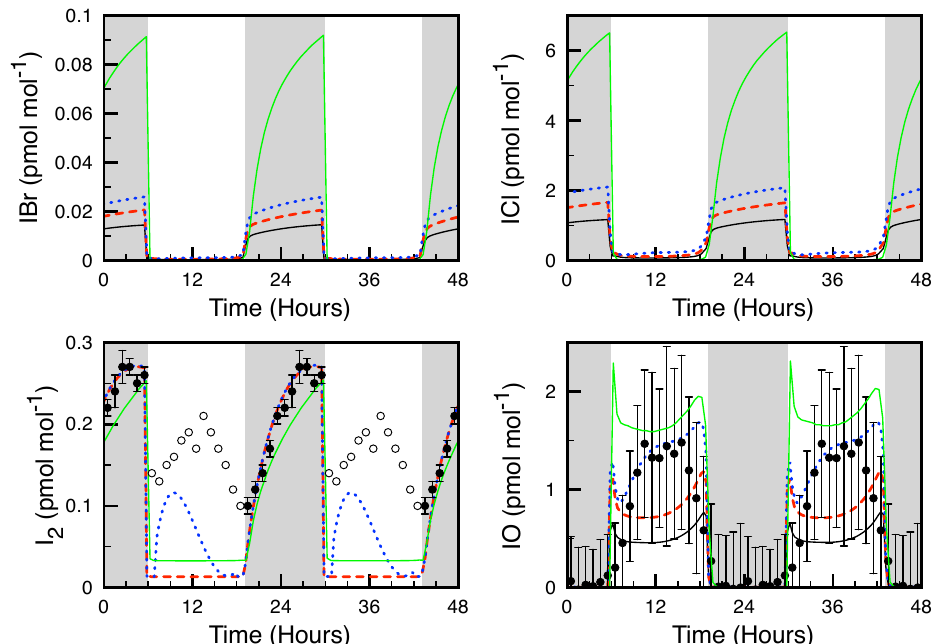
Fig. 7. THAMO box model results for four simulations. BASE (halocarbons only): black solid line. FLAT (constant I 2 flux): red dashed line. PHOTO (enhanced daytime I 2 source): dotted blue line. HOI (added flux of HOI): green solid line. Average I 2 and IO observations plotted as circles with one standard error bars. The upper limit daytime I 2 observations are plotted as open circles. Dark shading represents nighttime